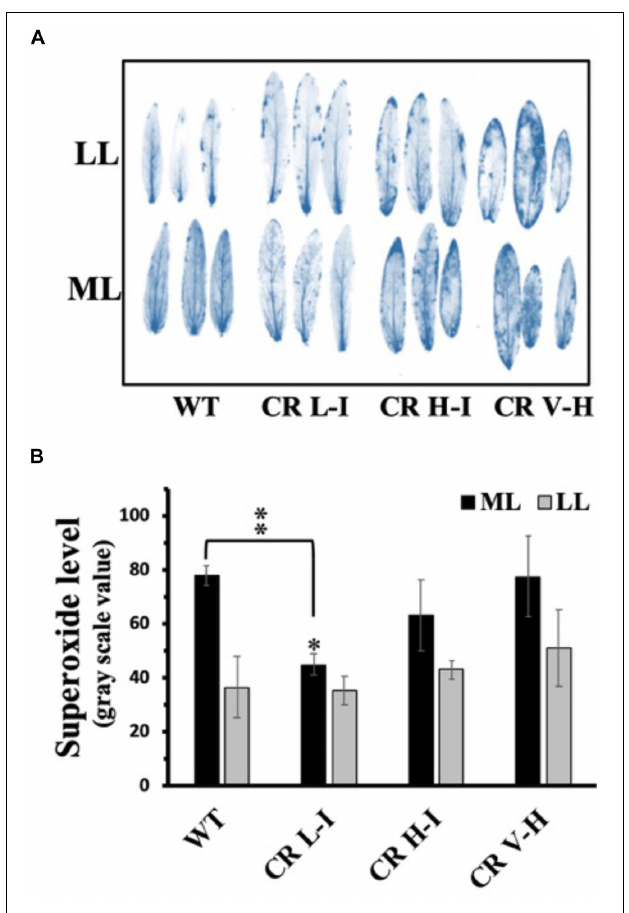
FIGURE 4 | Comparison of superoxide anion radical production in wild-type and CAO RNAi transgenic lines. Moderate light (ML) (850 µ mol photons m − 2 s − 1 ) and low light (LL) (200 µ mol photons m − 2 s − 1 ) grown wild-type (WT), CR L-I (Chl a/b = 4.5–6.5), CR H-I (Chl a/b = 6.5–8.5) and CR V-H (Chl a/b 8.5 or above) transgenic plant leaves were treated with nitroblue tetrazolium (NBT) for histochemical staining for superoxide production during illumination at ML or LL for 4 h (A) . Quantitative levels of the superoxide produced were analyzed from the image in grayscale value using Image J (rsb.info.nih.gov/ij) (B) . All experiments were done using fully expanded leaves from the top of 4–5 weeks old plants. Results represent the average and SD of three independent measurements. ∗ , values are significantly different at P < 0.05 and ∗∗ , values are significantly different at P < 0.01 between experimental groups.